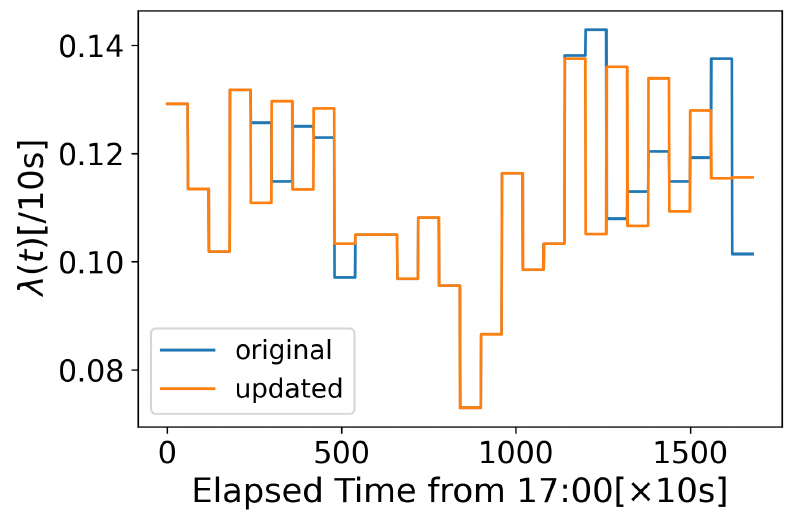
Figure 13. Original Scenario 0 and updated Scenario 6.